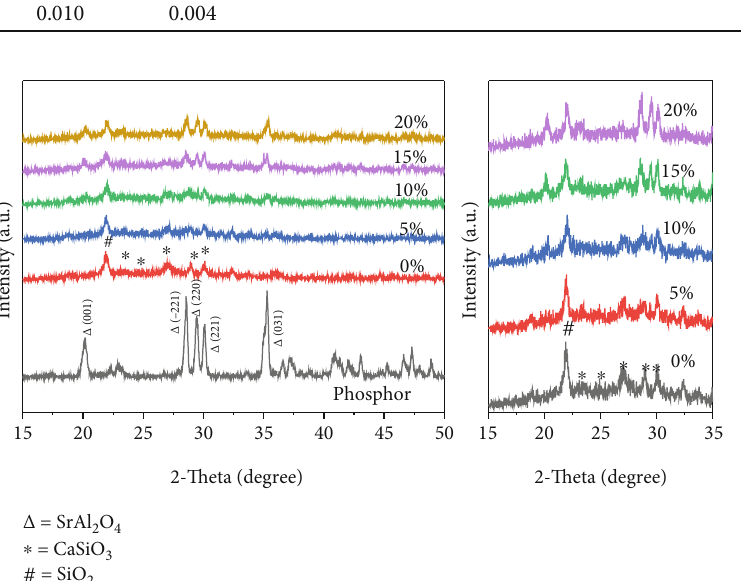
Figure 1: XRD patterns of bare phosphor and phosphor-in-glass ceramic aggregates with varying phosphor contents. The samples were sintered at 750 ° C for 30 min. The image in (b) is a zoom for CaSiO